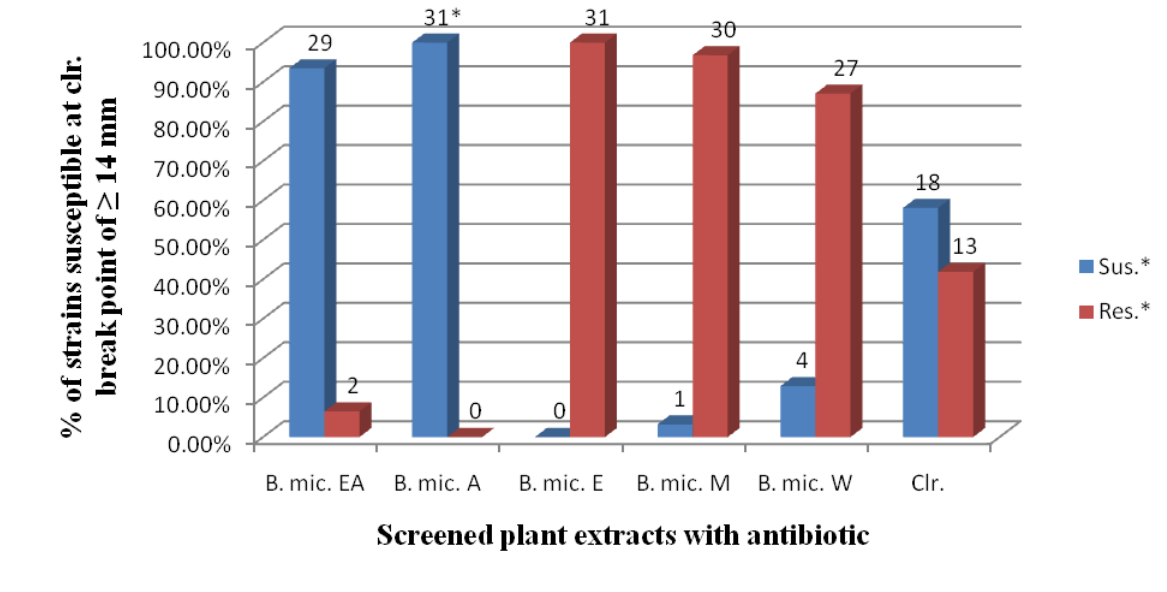
Figure 1. Plant extracts and antibiotic susceptibility against 31 strains of H. pylori .